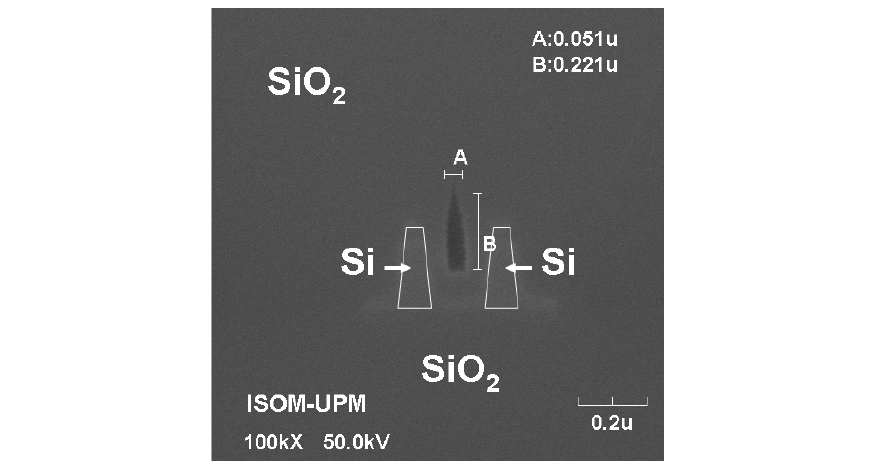
Figure 7. Cross-sectional SEM image of a void nanochannel obtained by plasma-enhanced on a SOI slot-waveguide configuration. chemical vapor deposition (PECVD) of SiO 2 Courtesy of D. López-Romero (ISOM-Universidad Politécnica de Madrid).